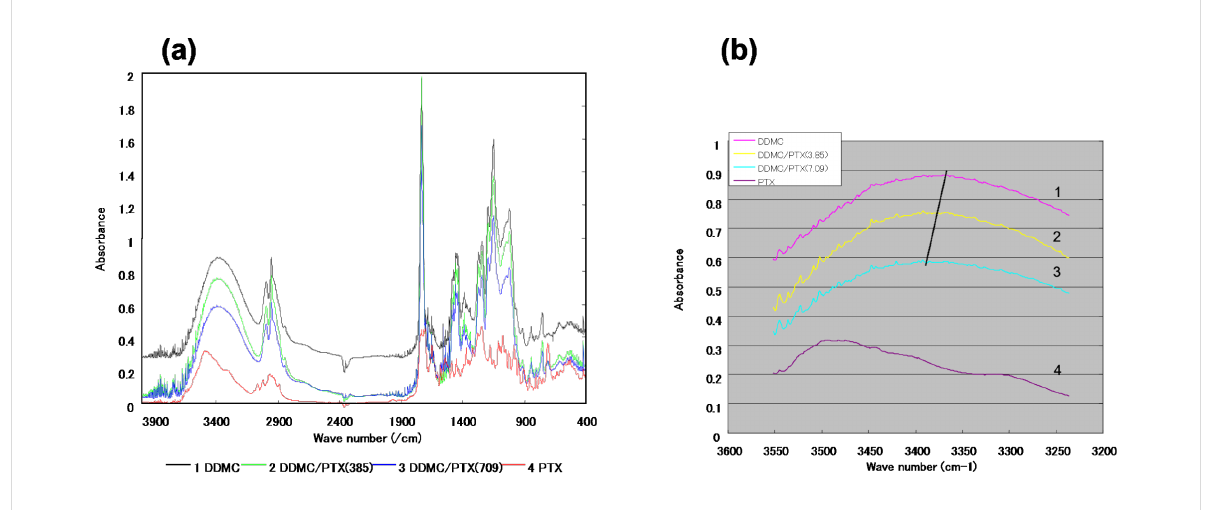
Figure 3: IR absorption spectra of the DDMC–paclitaxel complex and paclitaxel. (a) Mid-infrared region (4.000–400 cm − 1 ), (b) X–H stretching region: (1) DDMC, (2) DDMC/PTX complex (DDMC 9.6 mg/PTX 0.385 mg), (3) DDMC/PTX complex (DDMC 9.6 mg/PTX 0.709 mg), and (4) PTX. (b): Reprinted from